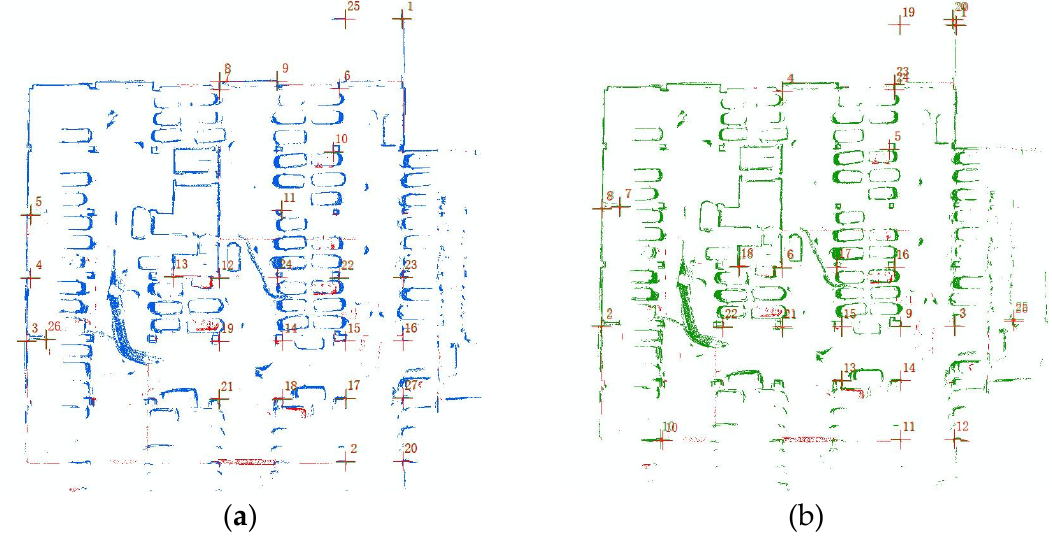
Figure 6. ( a ) MAP_ I: Mapping result of adding control network constraints; ( b ) MAP_III: Mapping result without control network or loop closure constraints. Figure 6. (a) MAP_ I: Mapping result of adding control network constraints; ( b )MAP_III: Mapping result without control network or loop closure constraints. Table 1. RMS (Root Mean Square) comparison of di ff erent mapping Table 1. RMS (Root Mean Square)comparison of different mapping results.